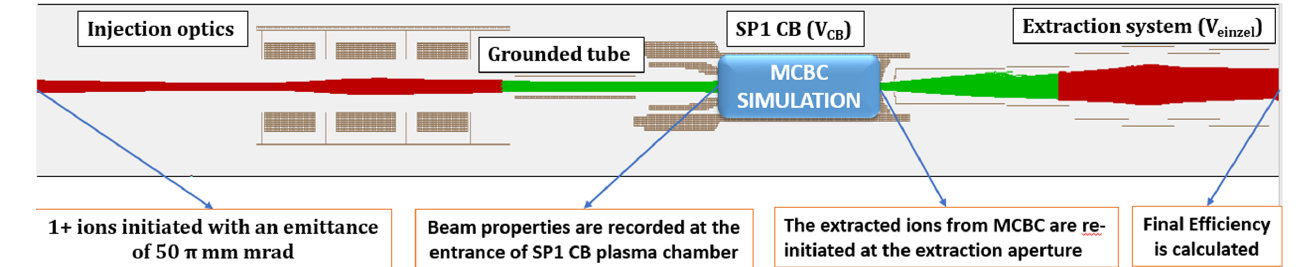
FIG. 4. The simulation approach implemented to perform MCBC